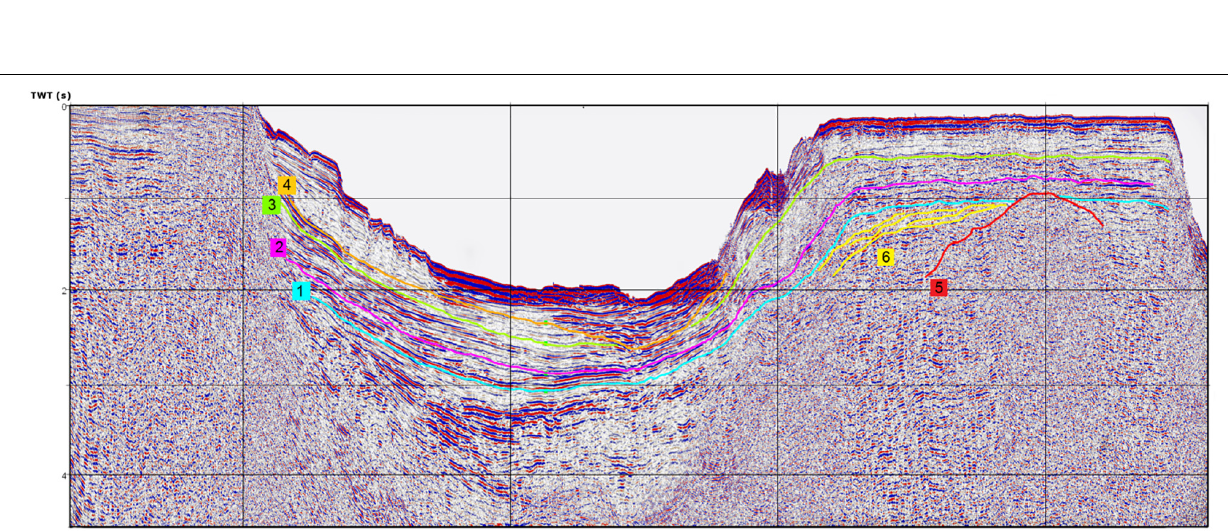
Frontiers in Earth Science |